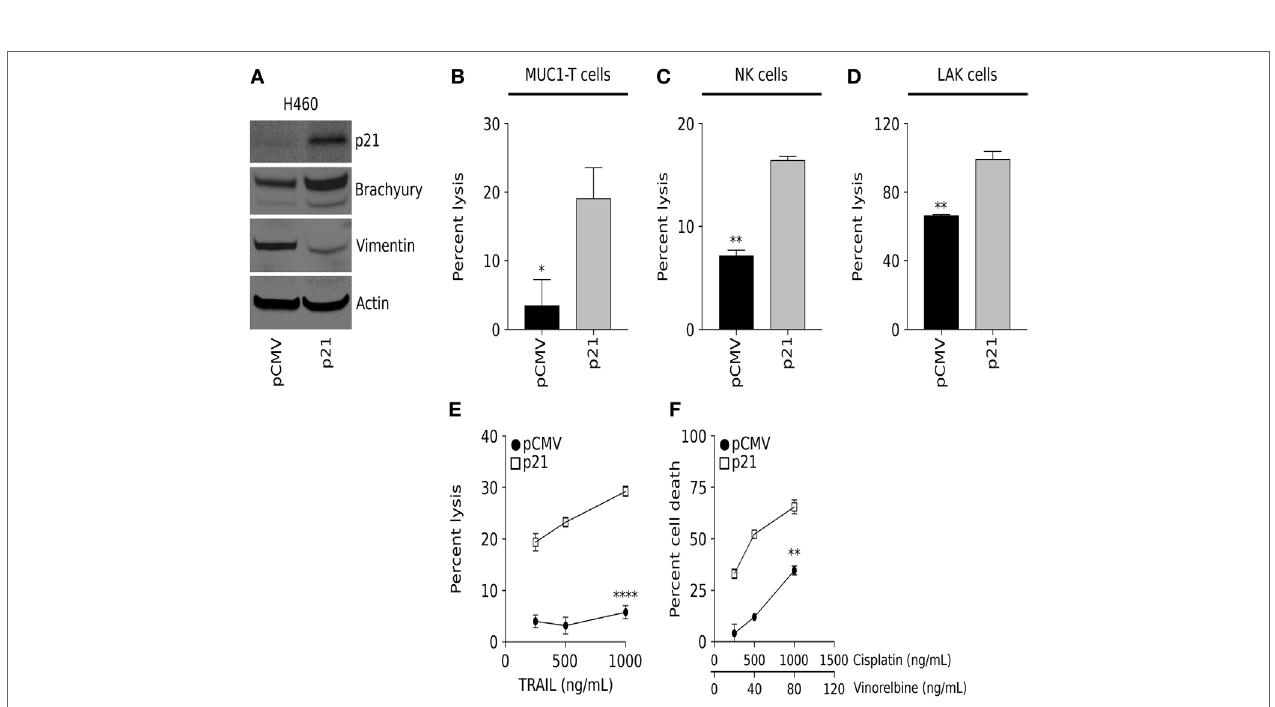
FigUre 3 | Overexpression of p21 in the brachyury-high H460 cell line increases sensitivity to lysis by both immune cells and chemotherapy. (a) Western blot analysis of p21, brachyury, and vimentin in H460 cells transfected to express either a control pCMV or a vector encoding p21 (p21). Sensitivity of H460-pCMV vs. H460-p21 cells to killing by (B) MUC-1-specific T cells (E:T ratio 30:1); (c) natural killer (NK) cells (E:T ratio 30:1); (D) lymphokine-activated killer (LAK) cells (E:T ratio 30:1); and indicated concentrations of (e) TNF-related apoptosis-inducing ligand (TRAIL) and (F) chemotherapy. NK and LAK lysis data presented is representative of data obtained using effector cells isolated from two different normal donors. TRAIL and chemotherapy data presented are representative of two independent experiments.